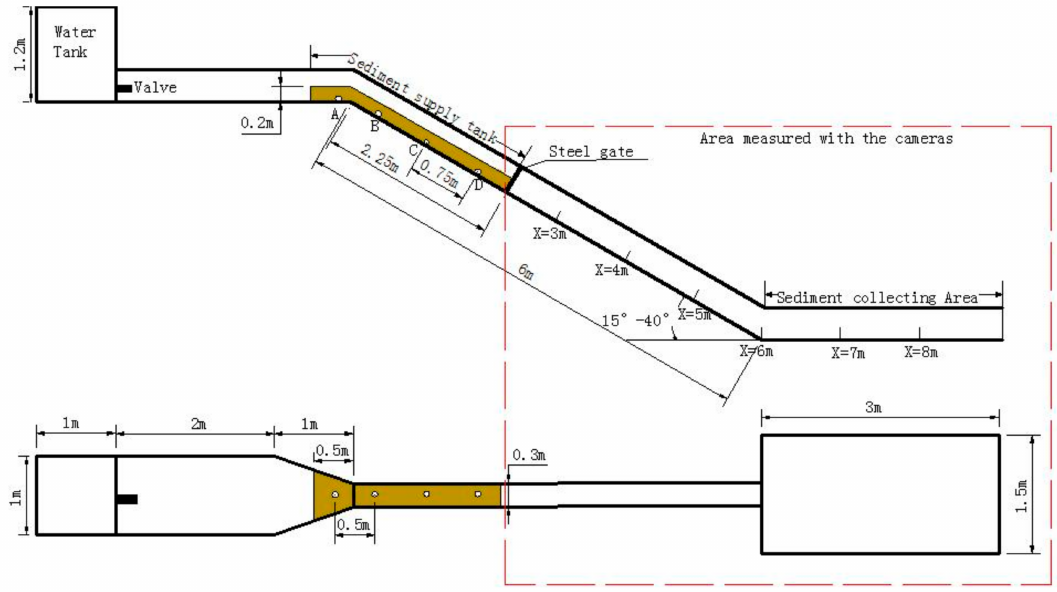
Figure 3. Schematic of the experimental flume. The measurement area recorded by the cameras is highlighted by a dash red